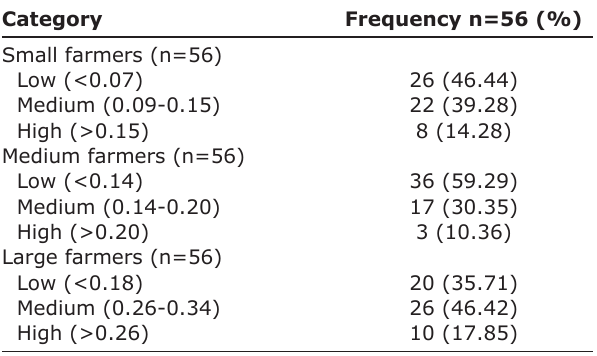
Table-6: Distribution of respondents as per usage pattern of antibiotics (n=168). Category